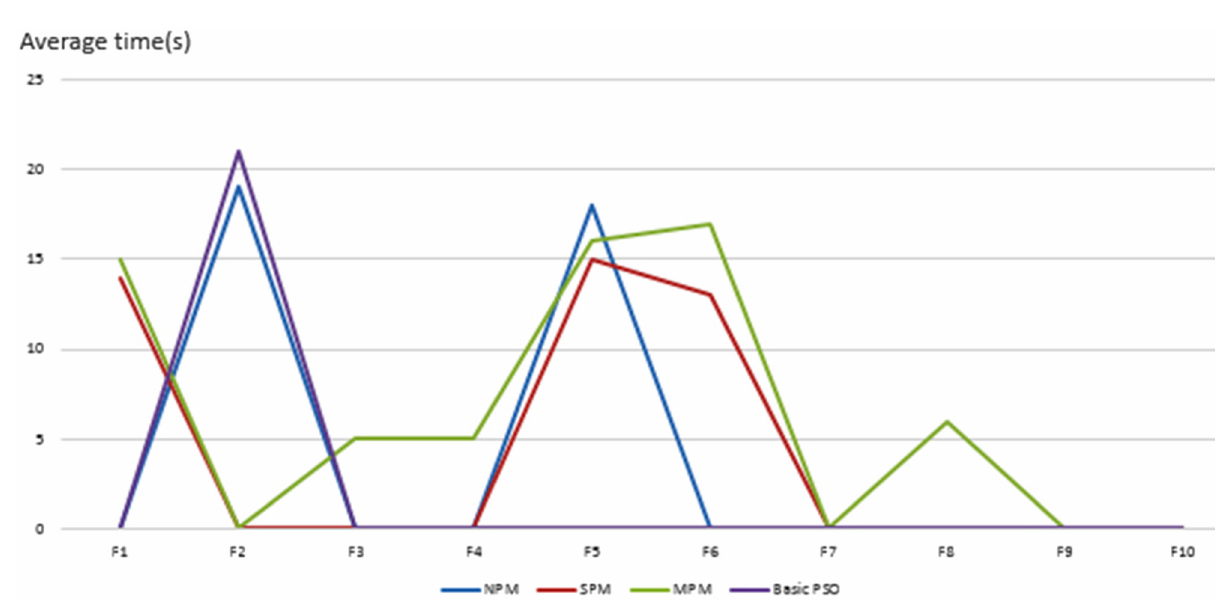
Fig. 7. Computation time performance for NPM, MPM, and SPM models.